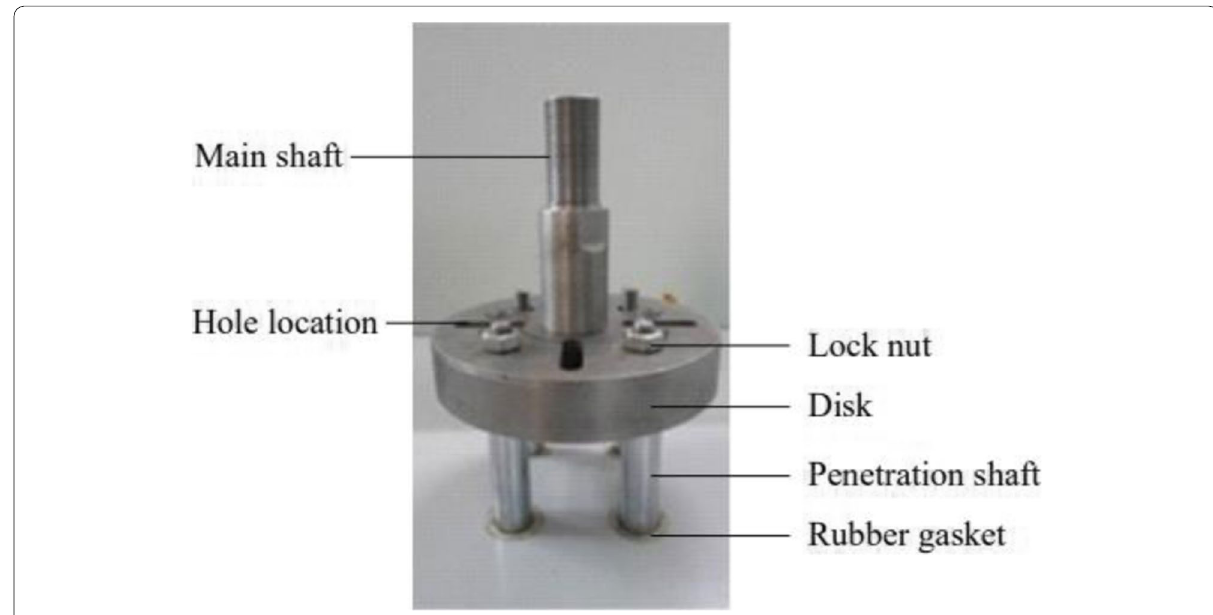
Fig. 2 Apparatus of the multi-point penetration